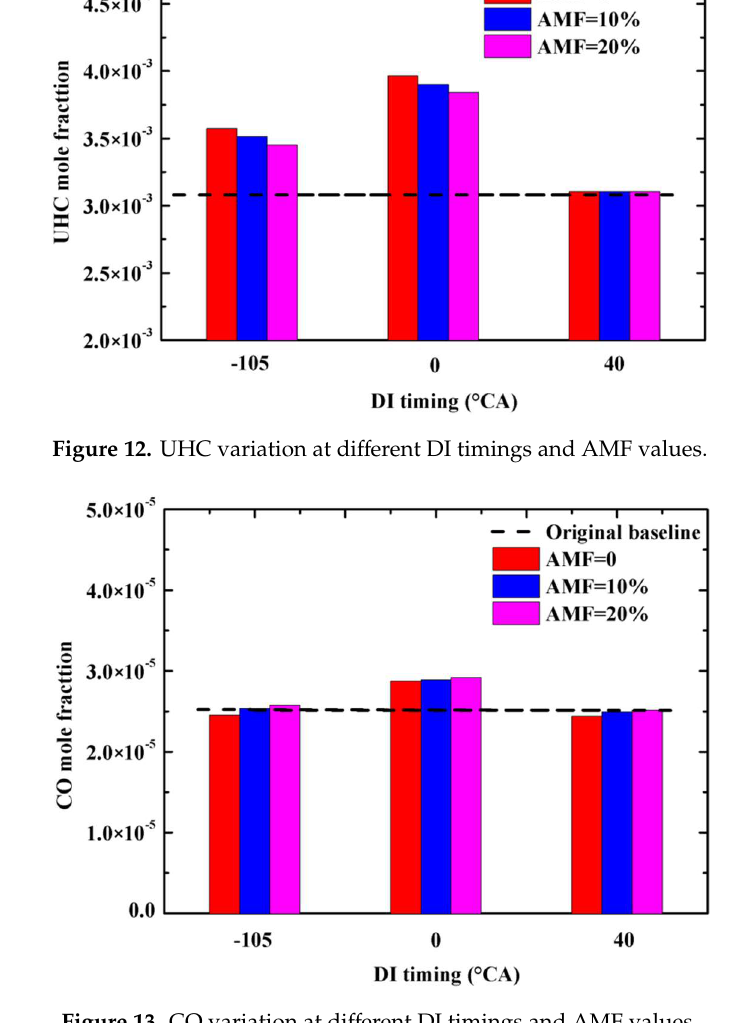
Figure 13. CO variation at different DI timings and AMF values.